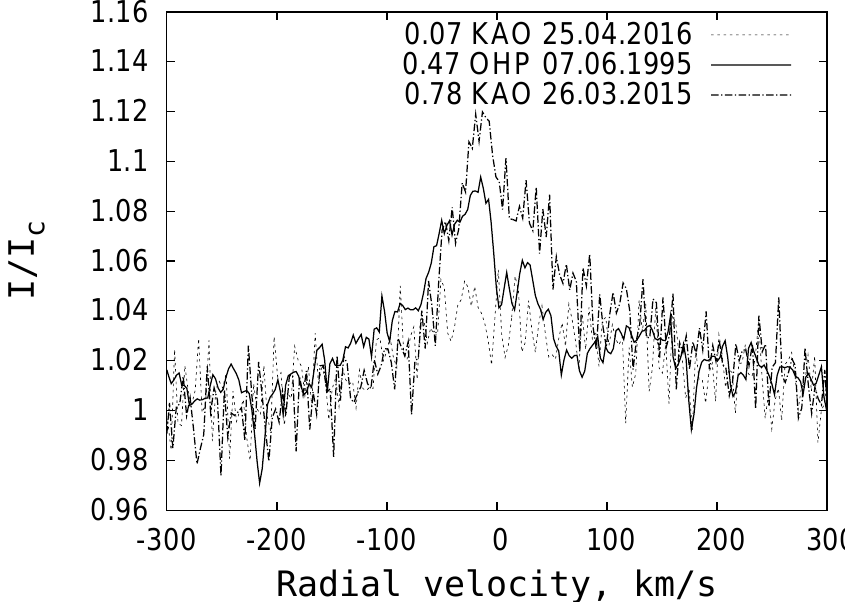
Fig. 1. Profiles of the Si II 6347 line in the spectra of HD 200775 taken at different epochs. The spectra were taken in KAO UrFU (Kourovka Astronomical Observatory of the Ural Federal University) and OHP (Haute-Provence Observatory). Numbers indicate orbital phases for each